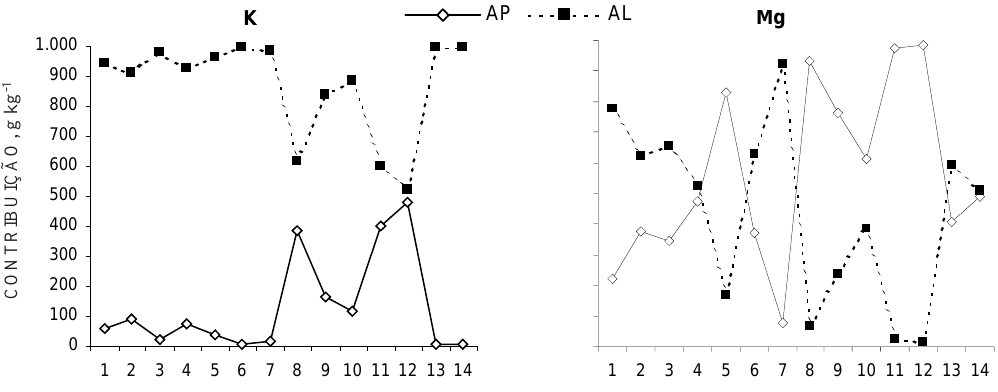
Figura 2. Contribuição das frações areia pesada (AP) e areia leve (AL) nos teores totais de K e Mg da areia total